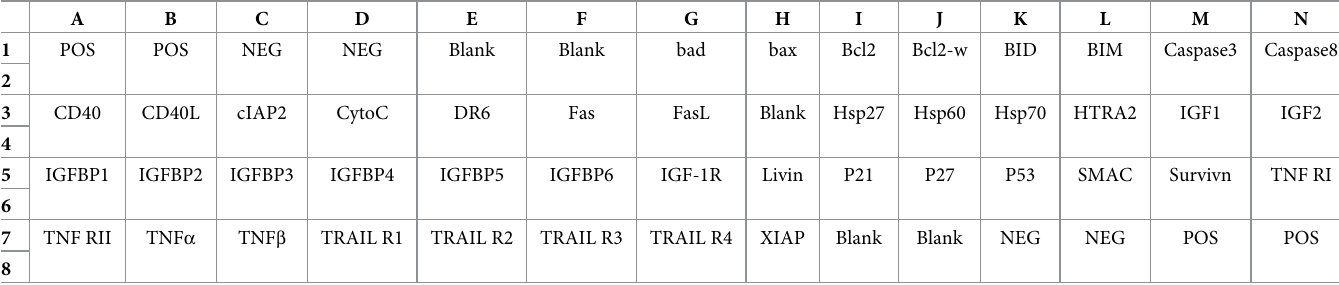
Table 1. The mini map of Human Apoptosis Array C1 (according to RayBio 1 manufacturer manual).